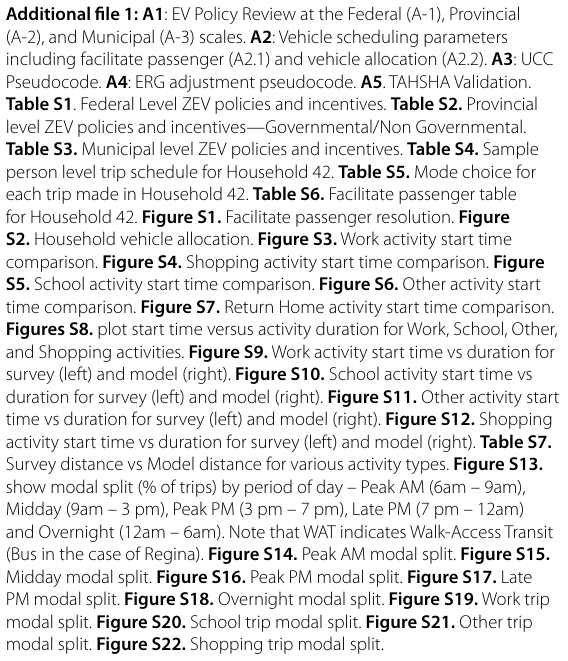
Table S1 . Federal Level ZEV policies and incentives. Table S2. Provincial level ZEV policies and incentives—Governmental/Non Governmental. Table S3. Municipal level ZEV policies and incentives. Table S4. Sample person level trip schedule for Household 42. Table S5. Mode choice for each trip made in Household 42. Table S6. Facilitate passenger table for Household 42. Figure S1. Facilitate passenger resolution. Figure S2. Household vehicle allocation. Figure S3. Work activity start time comparison. Figure S4. Shopping activity start time comparison. Figure S5. School activity start time comparison. Figure S6. Other activity start time comparison. Figure S7. Return Home activity start time comparison. Figures S8. plot start time versus activity duration for Work, School, Other, and Shopping activities. Figure S9. Work activity start time vs duration for survey (left) and model (right). Figure S10. School activity start time vs duration for survey (left) and model (right). Figure S11. Other activity start time vs duration for survey (left) and model (right). Figure S12. Shopping activity start time vs duration for survey (left) and model (right). Table S7. Survey distance vs Model distance for various activity types. Figure S13. show modal split (% of trips) by period of day – Peak AM (6am – 9am), Midday (9am – 3 pm), Peak PM (3 pm – 7 pm), Late PM (7 pm – 12am) and Overnight (12am – 6am). Note that WAT indicates Walk-Access Transit (Bus in the case of Regina). Figure S14. Peak AM modal split. Figure S15. Midday modal split. Figure S16. Peak PM modal split. Figure S17. Late PM modal split. Figure S18. Overnight modal split. Figure S19. Work trip modal split. Figure S20. School trip modal split. Figure S21. Other trip modal split. Figure S22. Shopping trip modal